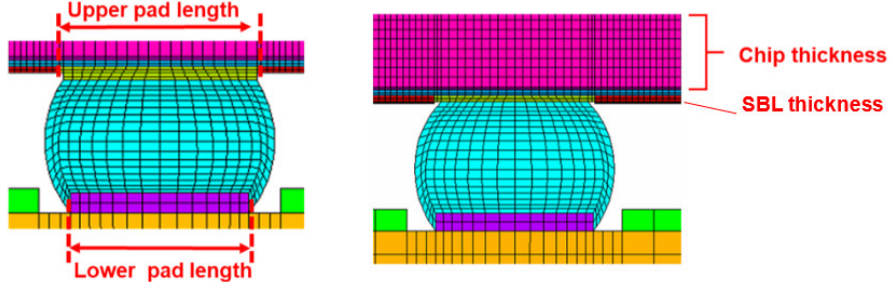
7 of 13 Figure 6. Thermal cycling temperature profile. After eight cycles, the incremental equivalent plastic strain will be stabilized, and it can be input to the Coffin–Manson equation to calculate the reliability prediction life of WLP. The reliability life between experiment and simulation is shown in Table 5. We can see that the difference between experiment and simulation prediction reliability life falls within an acceptable range for five test vehicles. Therefore, the WLP simulation models can be trusted. This study uses a validated simulation procedure and a controlled mesh size, as well as an automatic model generation technique we developed to create a large database of different design parameters and use it for machine learning. Table 5. Reliability comparison for six test vehicles. Test Vehicles Experiment Reliability Life (Cycles)